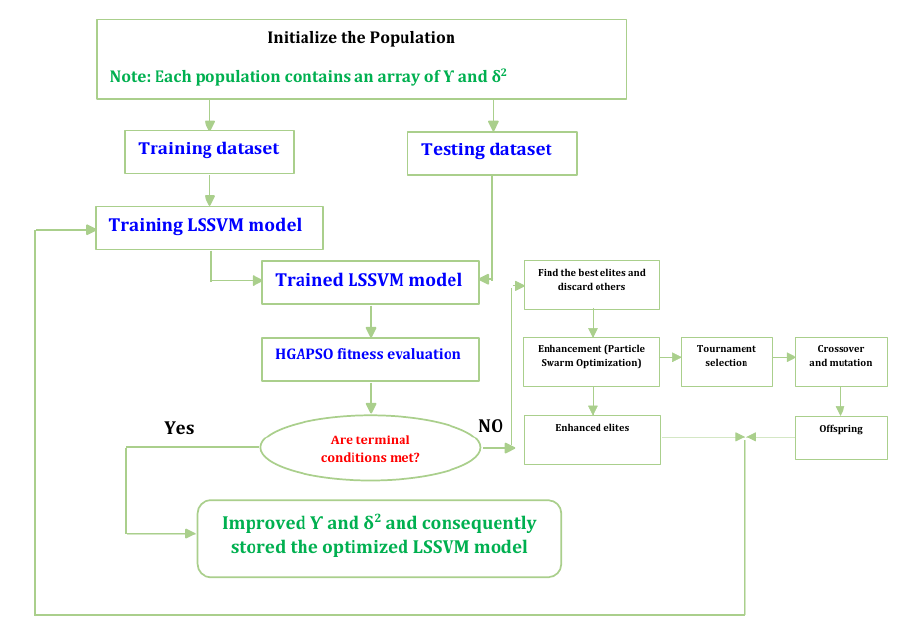
Figure 3. The overall scheme of the hybrid approach of PSOGA-least squares support vector machine method